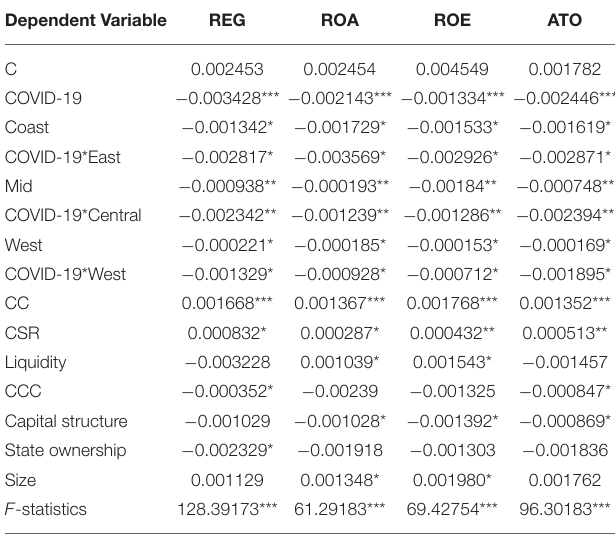
TABLE 7 | Generalized linear regression in high-risky regions.